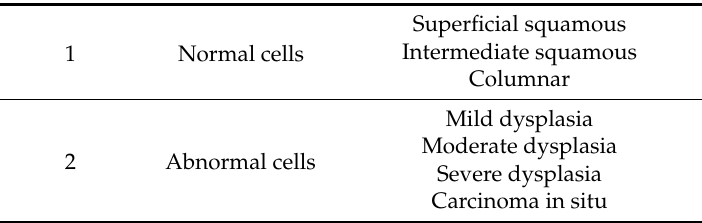
Table 1. Classification of Pap smear single image cell types.